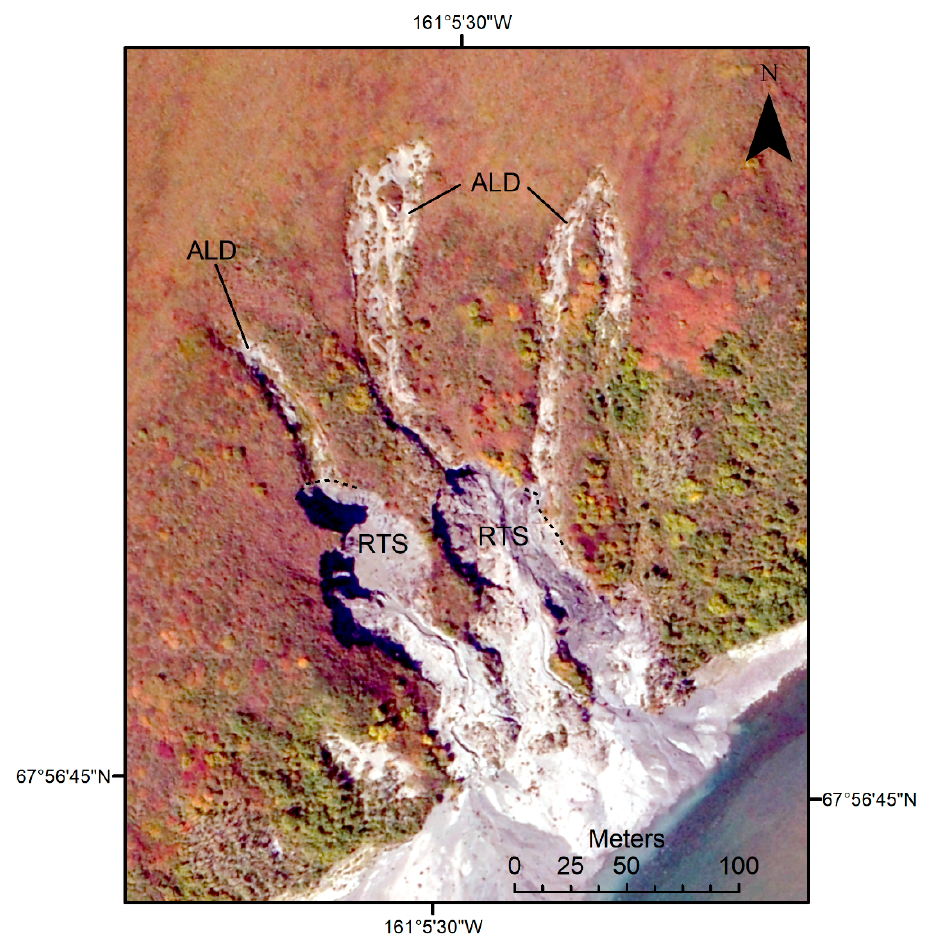
Figure 12. Main scarp of slump NOAT151 in an area that had previously slumped and revegetated. About 1.5 m of reworked glacial till ( A ) was over debris-rich glacial ice ( B ). The mud-water slurry formed by melt at the scarp is below ( C ).